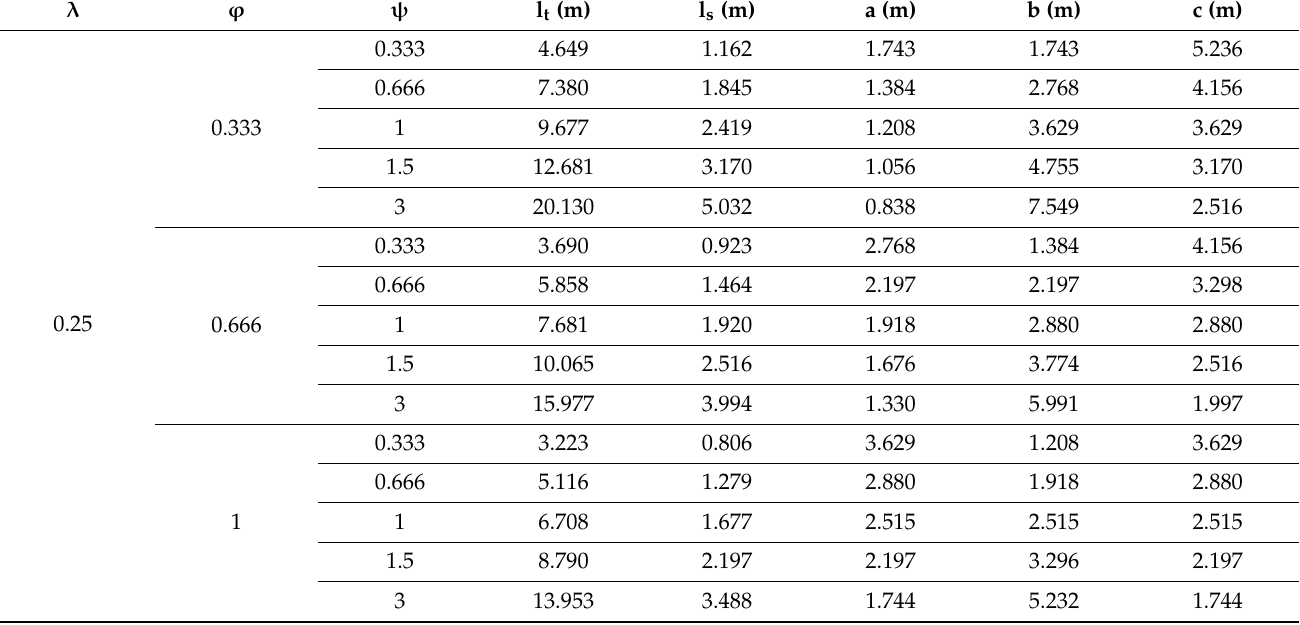
Table 4. Geometric characteristics of the tank configurations studied under constant